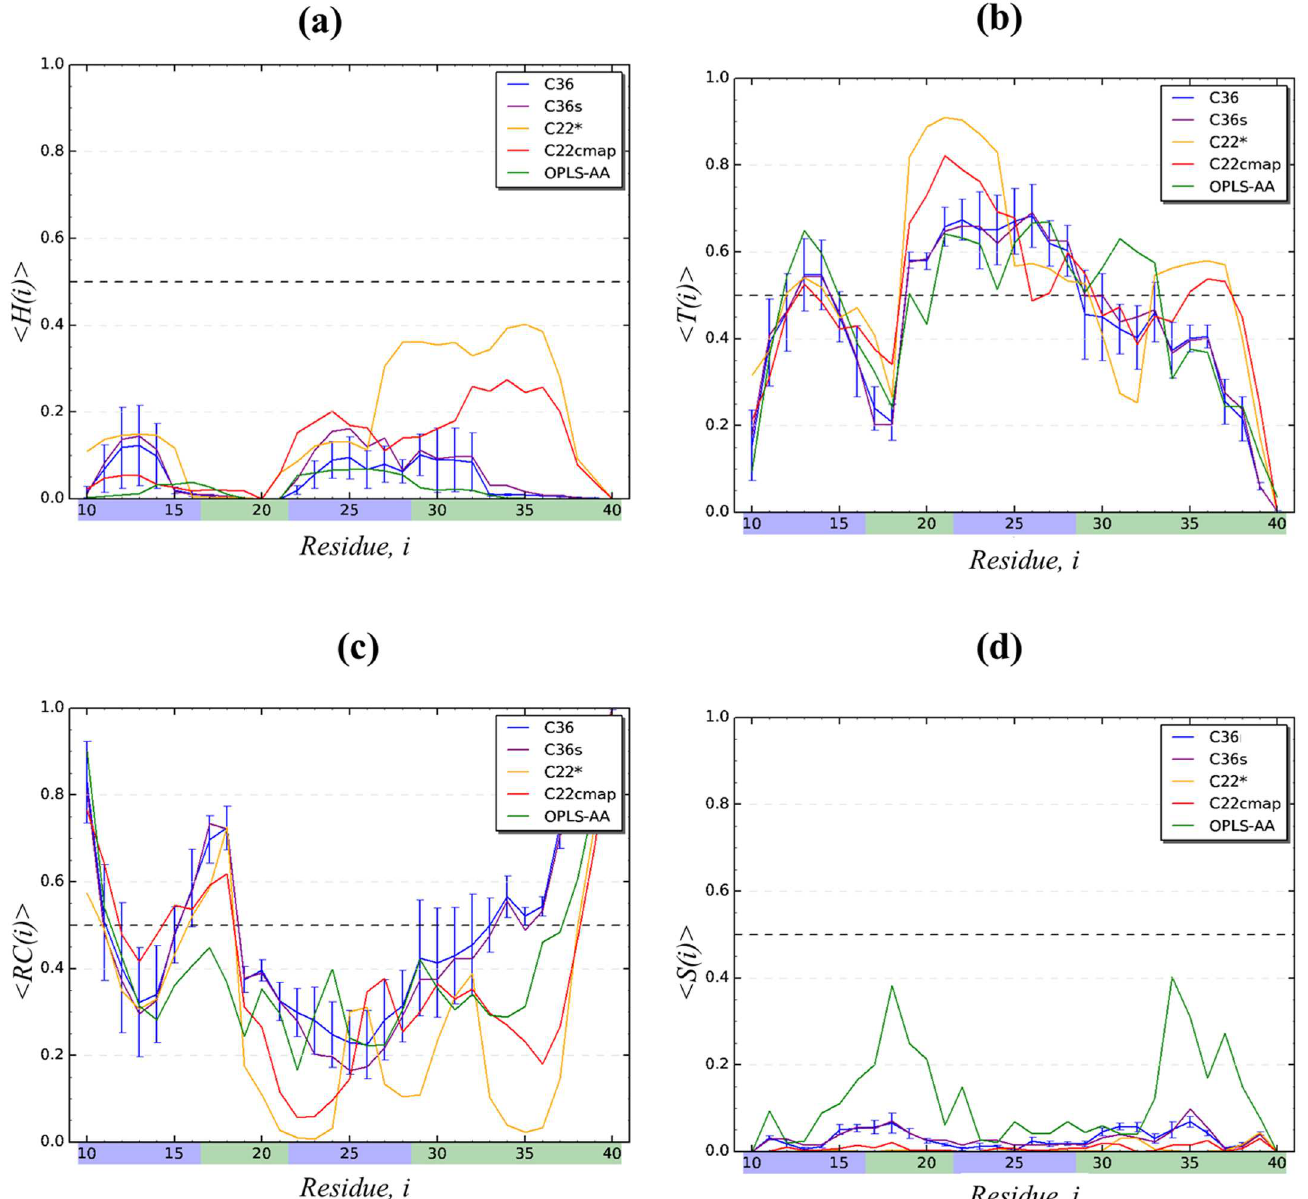
Fig 3. Residue-specific A β 10-40secondary structure in different force fields. Distributions of secondary structure in A β 10-40peptidewith respect to sequencepositions i for five force fields: (a) helix propensities h H ( i ) i ;(b) turn propensities h T ( i ) i ; (c) random coil propensities h RC ( i ) i ;(d) β propensities h S ( i ) i . For clarity, samplingerrors representedby vertical bars are shown for the C36 simulations only. Sequenceregionsare identified by the color scheme used in Fig 1a. C22 * force field displaysa significanthelix structure in S3 and S4 regions, and the OPLS-AA system has a propensity for β -structurein S2 and